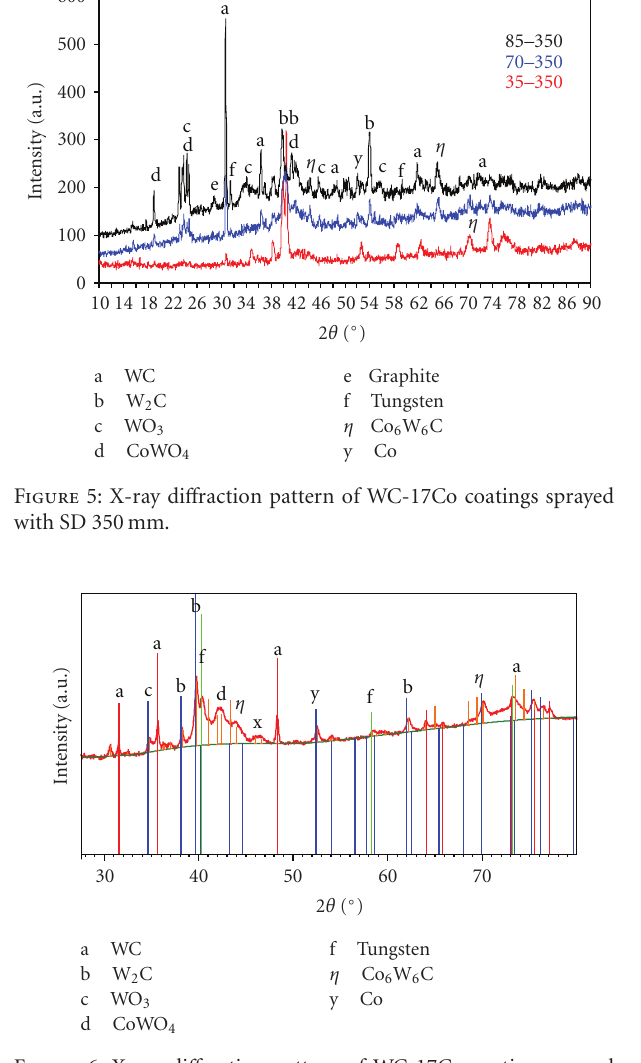
Figure 6: X-ray di ff raction pattern of WC-17Co coating sprayed with FD 115mm and SD 300 mm.